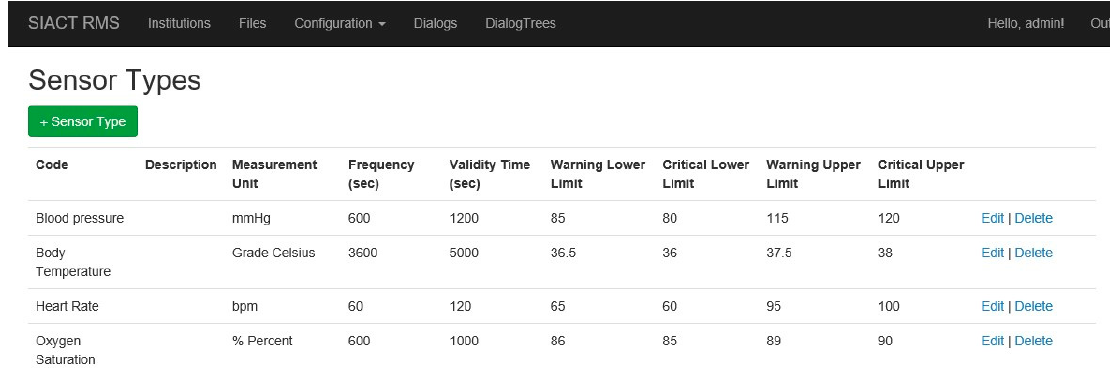
Figure 16. Defining the types of sensors used in the Patient WEB Application. Sensors 2019 , 19 , x